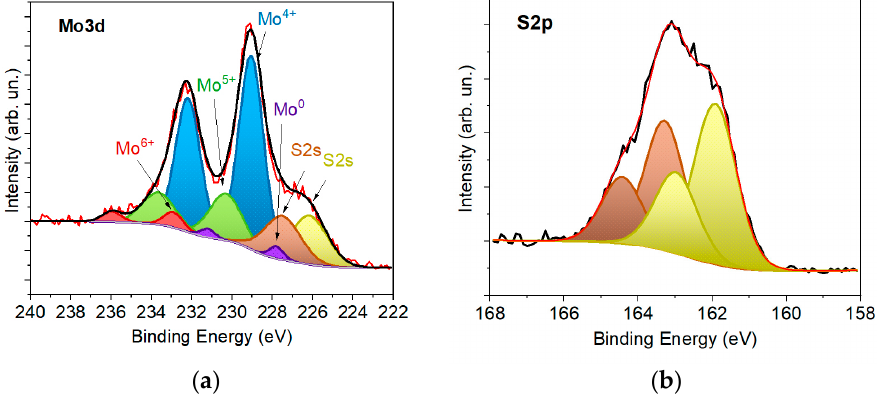
Figure 7. XPS ( a ) Mo3d and ( b ) S2p spectra for a 20 nm thick a-MoS x /NP-Mo film.